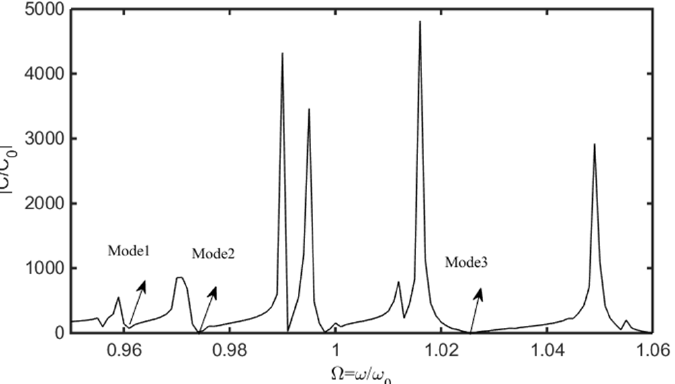
Figure 4. The relationship between the normalized frequency and capacitance ratio of the device.